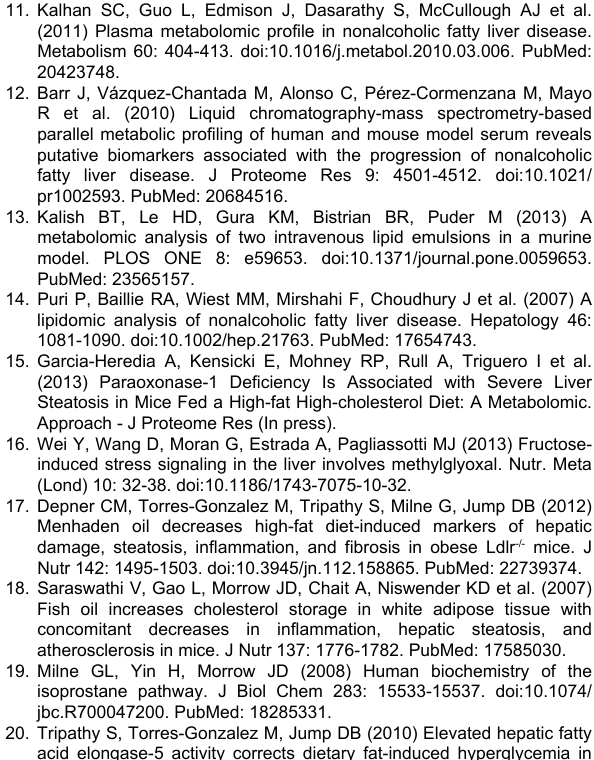
Table S1. Primer pairs used for qRT-PCR. (DOCX) Table S2. Volcano plot data comparing Chow versus WD + O fed mice. Volcano plots were prepared as described in Methods using software at (http://www.metaboanalyst.ca). This table represents the data used to construct Figure 3A.